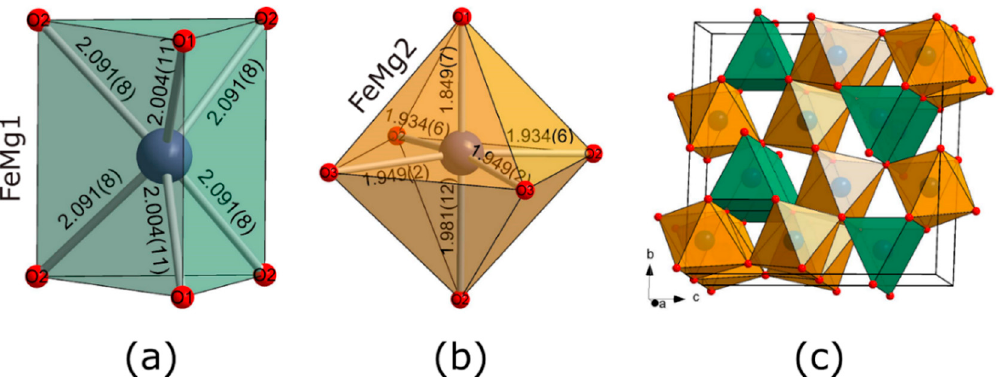
Figure 3. Coordination polyhedra of FeMg1 ( a ) and FeMg2 ( b ) crystallographic sites in the crystal structure of (Fe 1.82 ,Mg 1.18 )O 4 . The bond distances are given in angstroms. The crystal structure of (Fe 1.82 ,Mg 1.18 )O 4 ( c ) is built of trigonal prisms and octahedra (Fe,Mg)O 6 . Trigonal prisms share trigonal faces, while the octahedra connect through common edges. Oxygen atoms are shown as red spheres.